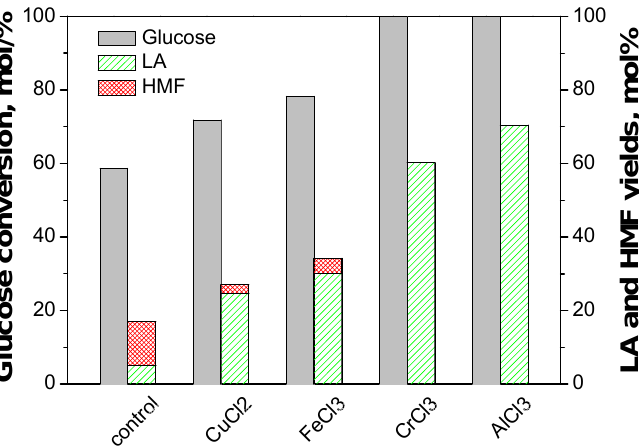
Figure 3. Catalytic effects of metal chlorides on the conversion of